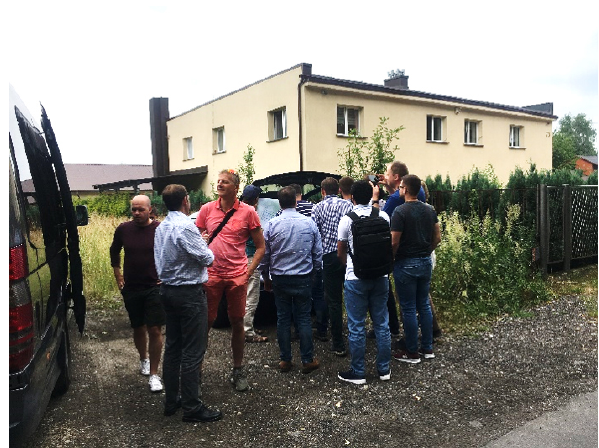
Figure 6. Field investigation on 2 July 2019 into underground min- ing (Fig. 5). Source: i 2 MON